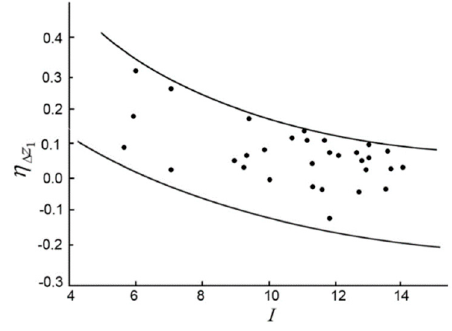
Figure 9. The relation between I and η ∆ z